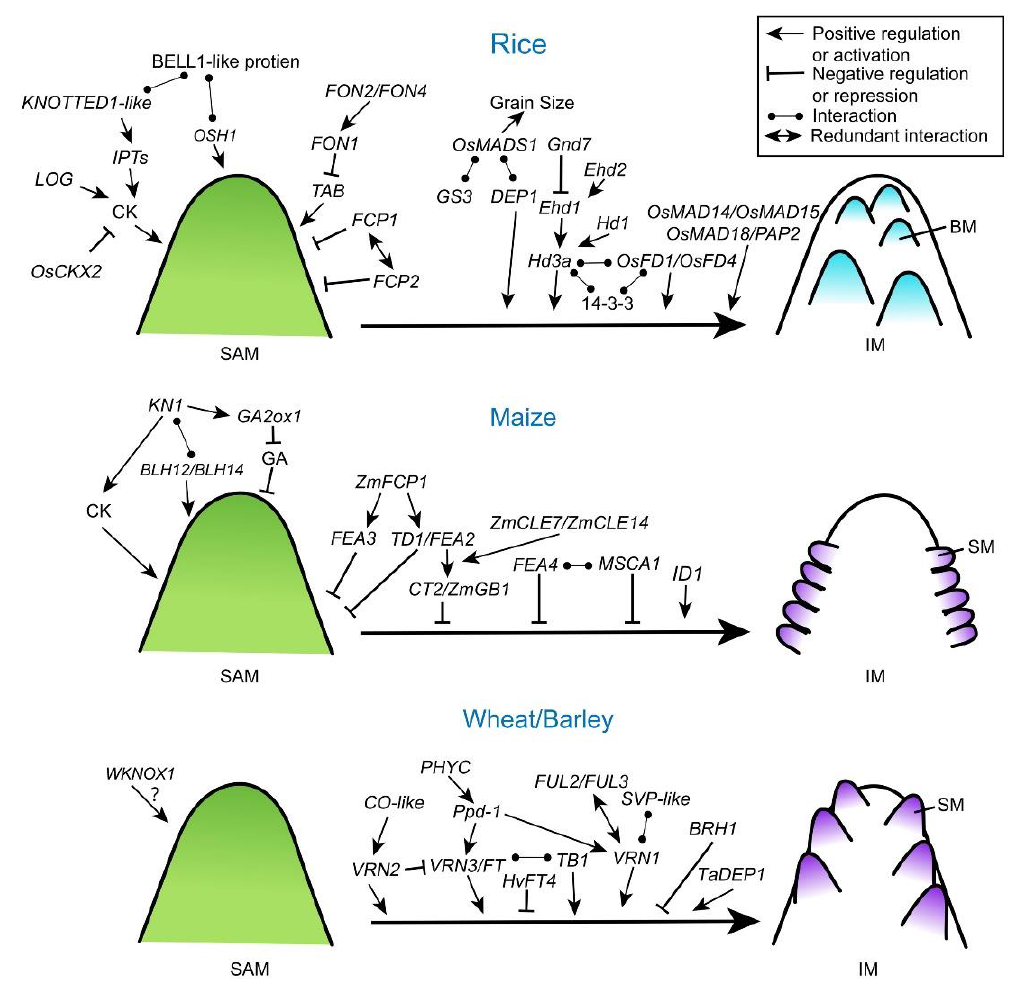
Figure 2. Key regulators and genetic pathways of phase transition from SAM to IM in cereal crops. Models for the roles of KNOX-type proteins, CLV signaling, G proteins, photoperiod pathway and MADS transcription factors in regulation of SAM size/activity and IM specification in rice, maize, wheat and barley. SAM, shoot apical meristem; IM, inflorescence meristem; BM, branch meristem; SM, spikelet